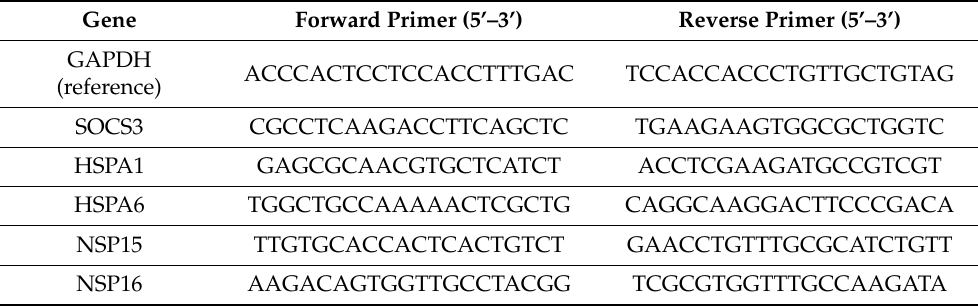
Table 1. Sequences of human gene primers for RT-qPCR validation or classical PCR